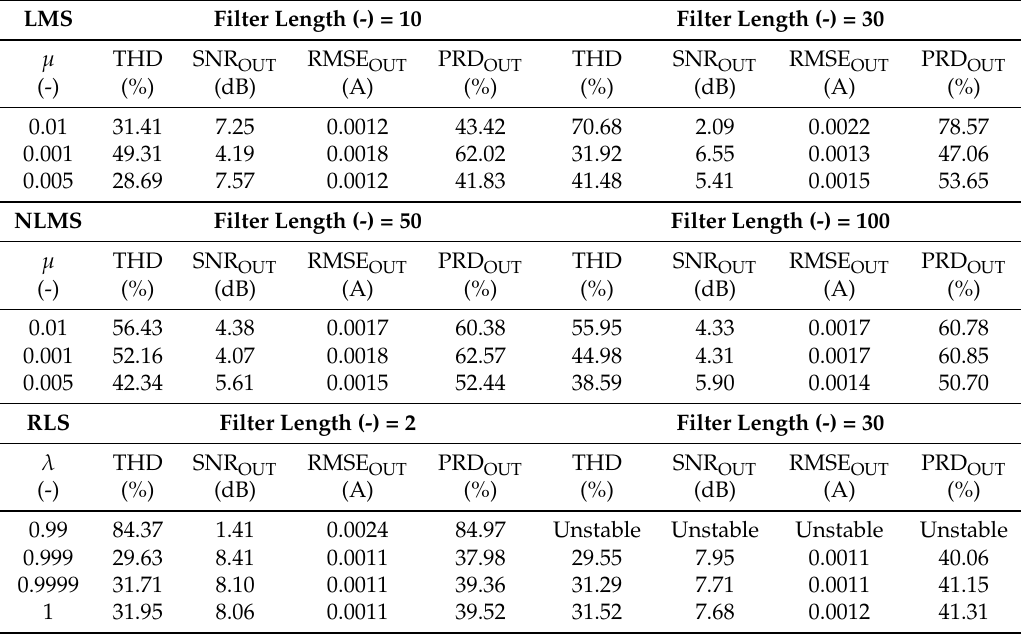
Table 2. Results of the experiment using adaptive algorithms for the initial stage (from 0 to 100 ms). LMS